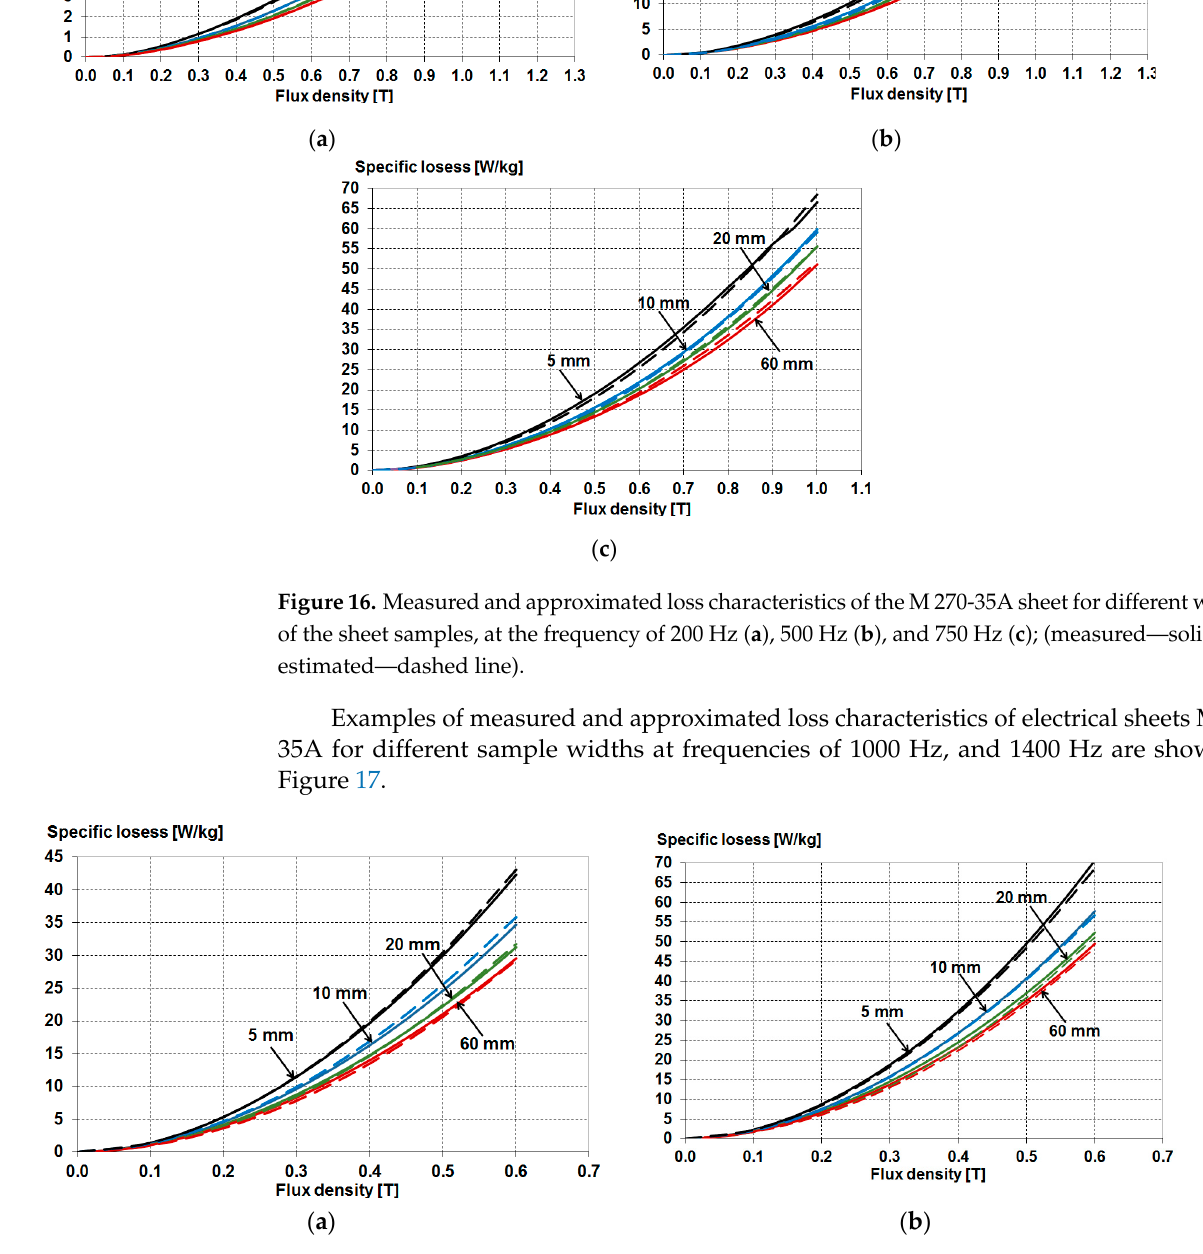
( b ) Figure 18. Measured and approximated loss characteristics of the M 270-35A sheet for different widths of the sheet samples, at the frequency of 2000 Hz ( a ), 3000 Hz ( b ); (measured—solid line, estimated—dashed line). Examples of measured and approximated loss characteristics of M270-35A electrical sheets for different sample widths at a frequency of 4000 Hz are shown in Figure 19a. The coefficients k h , k e , α , and β approximating the loss characteristics of electrical sheets M270-35A as a function of the sample width, determined for frequencies up to 4000 Hz, were used to determine the loss characteristics for frequencies higher than 4000 Hz (up to 14,400 Hz) in the magnetic induction range up to 0.2 T. (Figure 19b), for samples of different widths.